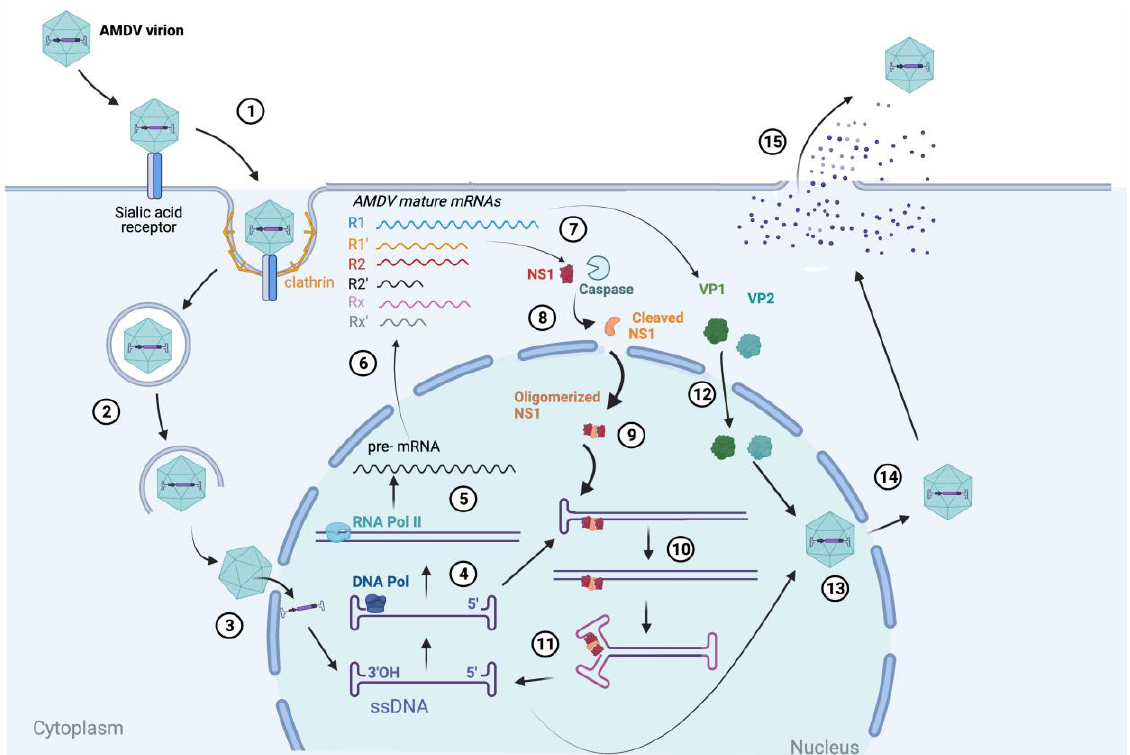
Figure 1. Proposed viral life cycle of Aleutian mink disease virus (AMDV). (1) The virus attaches and binds to the sialic acid receptor on host cells, triggering uptake by clathrin-mediated endocytosis. (2) Endolysosomal trafficking toward the nucleus. (3) Viral single-stranded DNA (ssDNA) genome is delivered into the nucleus. (4) Conversion of ssDNA into dsDNA by host cell DNA polymerase (DNA pol). (5) Transcription of double-stranded DNA (dsDNA) produces precursor mRNA (pre-mRNA) in the nucleus. (6) Splicing and polyadenylation of pre-mRNA yields six mature mRNAs, which exit the nucleus for (7) translation of viral proteins (only NS1, VP1 and VP2 shown). (8) Specifically, for AMDV: cleavage of NS1 protein by caspase proteins to facilitate localization of full-length NS1 to nucleus during permissive replication. (9) Full-length/cleaved NS1 oligomer enters the nucleus to covalently bind to the 5′ end of dsDNA, and (10) performs a nick. (11) Rolling hairpin replication (RHR) generates many copies of ssDNA genome. (12) Together, the VP1 and VP2 proteins enter the nucleus and (13) bind the ssDNA genome to form a mature AMDV virion. (14) Exit of AMDV virion from nucleus. (15) Release of AMDV virions through cell lysis. Created with BioRender.com (accessed on 15 August